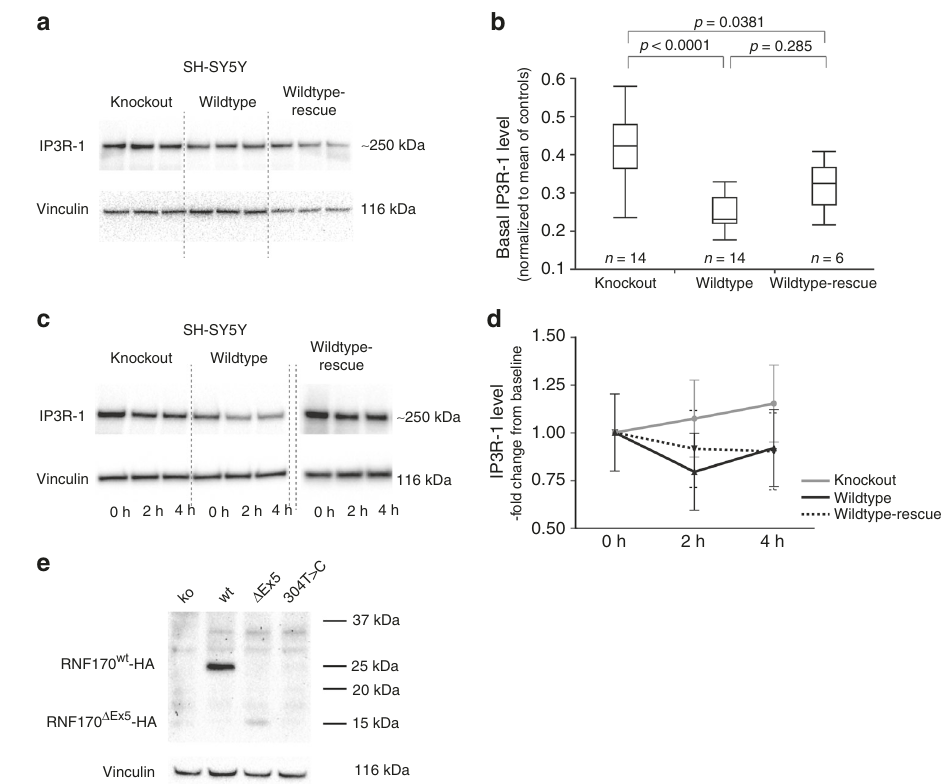
Fig. 3 Effect of RNF170 mutations on IP3R-1 degradation and abundance in neuronal cells. a , b Immunoblot analysis of IP3R-1 in wildtype and knockout SH- SY5Y cells (SH-SY5Y(RNF170 wt )/ n = 14 biologically independent samples; SH-SY5Y(RNF170 ko )/ n = 14 biologically independent samples) and after re- expression of RNF170 in a knockout background (SH-SY5Y(RNF170 ko (wt-HA))/ n = 6 biologically independent samples). SH-SY5Y(RNF170 ko ) cells demonstrate signi fi cant accumulation of IP3R-1 (ko: mean 0.437± 0.133; wt: mean 0.247 ± 0.043) that can be rescued by re-expression of